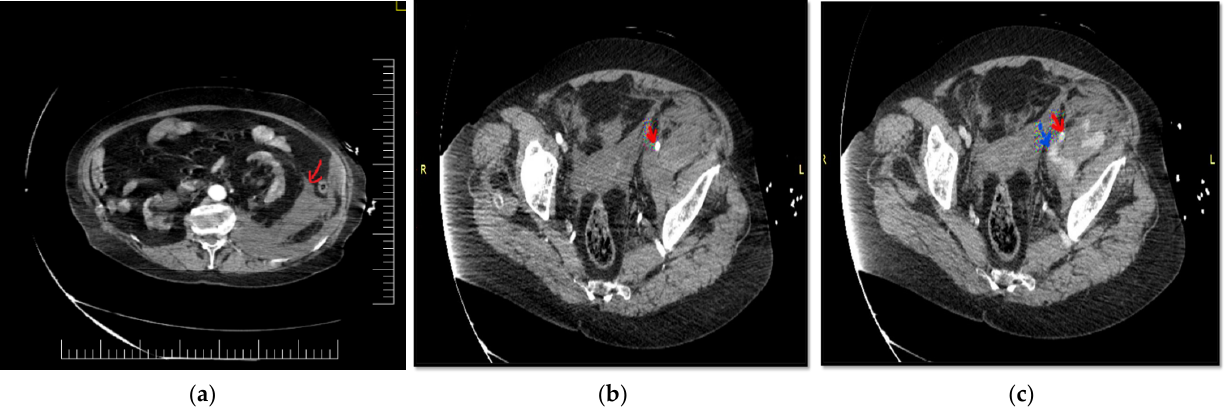
Figure 1. Contrast ‐ enhanced CT scan of an 83 ‐ year ‐ old woman that presented with intense pain in her left flank, left iliac fossa and left lower limb with a sudden onset of about 2–3 h after a medium physical exertion. When taken over by the emergency rescue service, the patient is conscious, agitated, and pale, with sweaty and cold skin. Blood pressure values are 90/50 mmHg, and the ventricular rate is 100 rpm. Personal pathological antecedents are hypertension and chronic ischemic heart disease for which it is treated with angiotensin receptor blocker, beta ‐ blocker, thiazide diuretic and antiplatelet therapy ‐ Aspenter ‐ acetylsalicylic acid. Clinical examination reveals pale, cold sweaty skin, a mobile abdomen with respiratory movements, and pain in the left flank and left iliac fossa that appear swollen compared to the contralateral area, giving an asymmetrical appearance to the abdomen, without signs of peritoneal irritation. Laboratory tests show: HB ‐ 8.7 g/dL, erythrocytes 3 × 106/uL, Leukocytes 10.2 × 103, INR 1.55, APTT 23.3 sec, Urea 53.8 mg/dL, Creatinine 1.76 mg/dl. Blood type and Rh are determined. Intravenous fluid resuscitation is started, and the suspicion of a massive retroperitoneal hematoma is raised; a contrast ‐ enhanced emergency CT examination is performed that confirms the diagnosis and detects a voluminous retroperitoneal hematoma of 24/12/12 cm anteriorly displacing the kidney and perirenal adipose tissue. The retroperitoneal hematoma is marked with a red arrow ( a ) . Contrast ‐ enhanced CT scan during the arterial phase reveals homogeneous opacified common and external iliac arteries. It is marked with a red arrow on the left external iliac artery ( b ). Contrast ‐ enhanced CT scan during the venous phase detects an enlarged left external iliac vein, with extravasation of contrast agent. It is marked with an interrupted blue arrow on the left external iliac vein, with contrast extravasation at this level. The continuous red arrow indicates the left external iliac artery, which is intact ( c ).